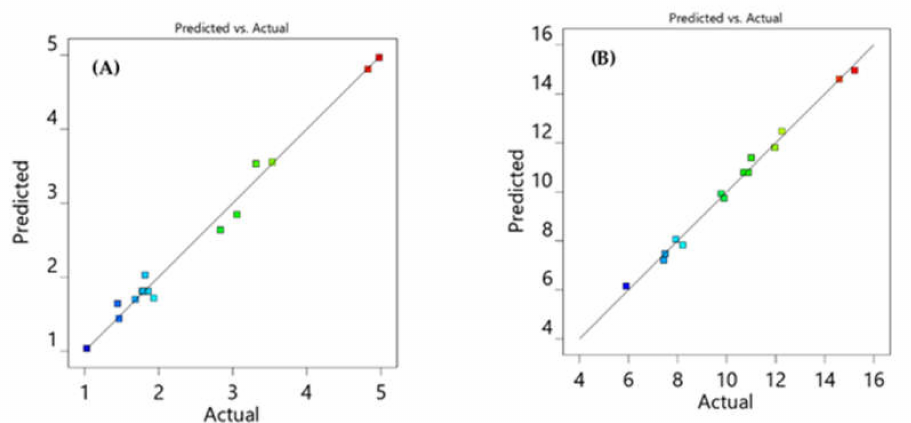
Figure 3. Diagnostic plots showing the predicted against actual values for resolution between VLG